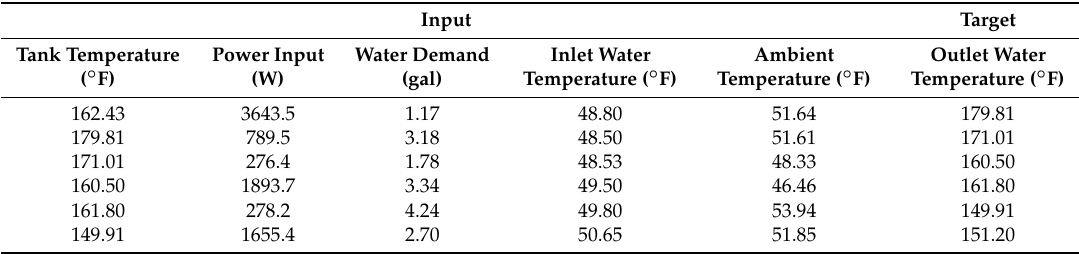
Table 1. Neural Network modeling input and target data (Note: T ( ◦ C) = ( T ( ◦ F) − 32) × 5/9, 1 gallon = 0.00378541 m 3